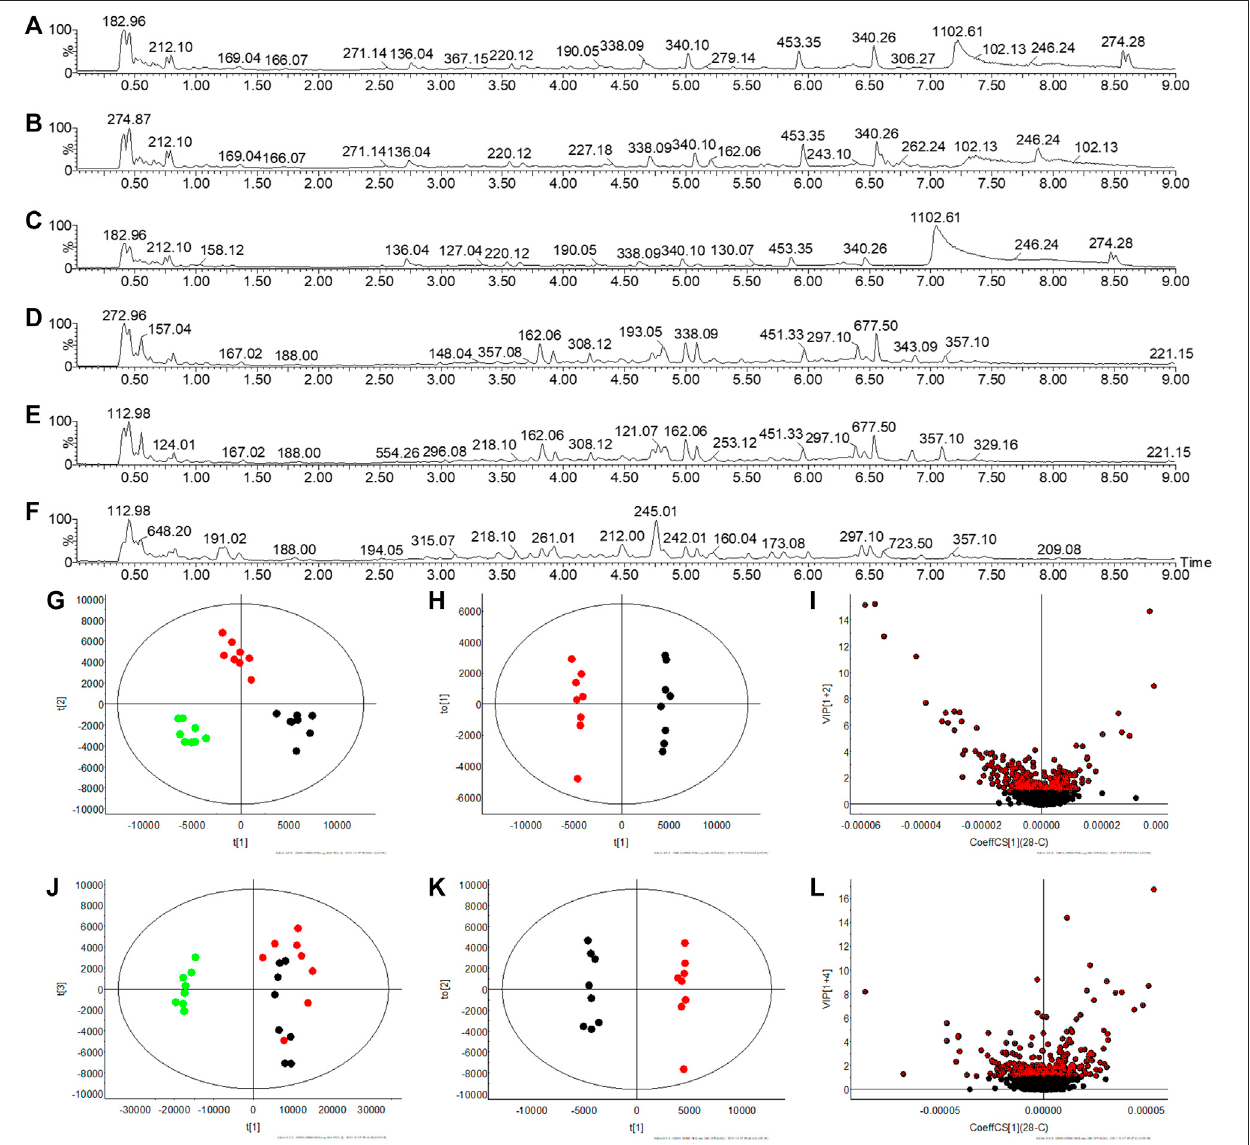
FIGURE4| Urine metabolic pro fi le collection and multivariate statistical analysis. (A – C) TIC spectraofC,M, and Trats inESI + , respectively (D – F) TIC spectraofC, M,andTratsinESI − ,respectively (G , J) PCAplotofC,M,andTinESI + andESI − ,respectively (H , K) OPLS-DAplotofCandMinESI + andESI − ,respectively (I , L) VIPplot of C and M in ESI + and ESI − , respectively. Note: : C rats; : M rats; : T rats.